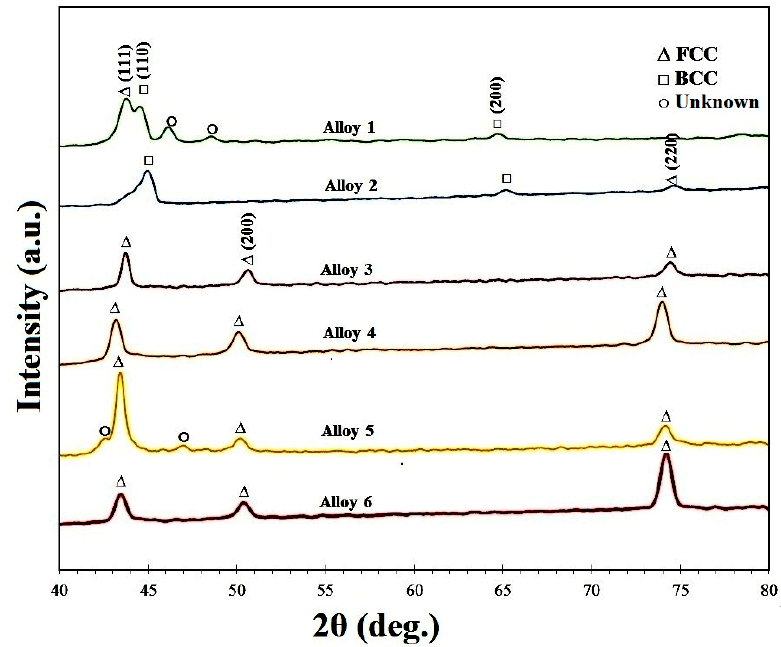
Figure 2. XRD patterns of the as-cast six HEAs.